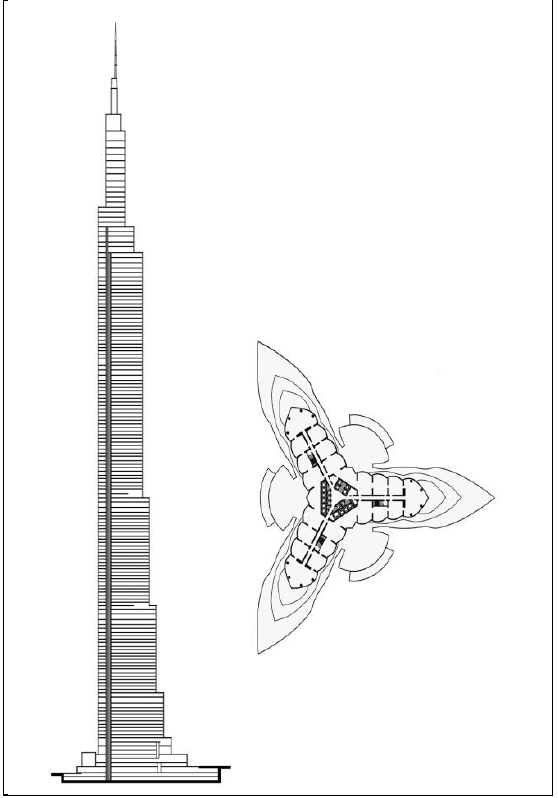
Figure 12. Burj Khalifa (photograph by authors).